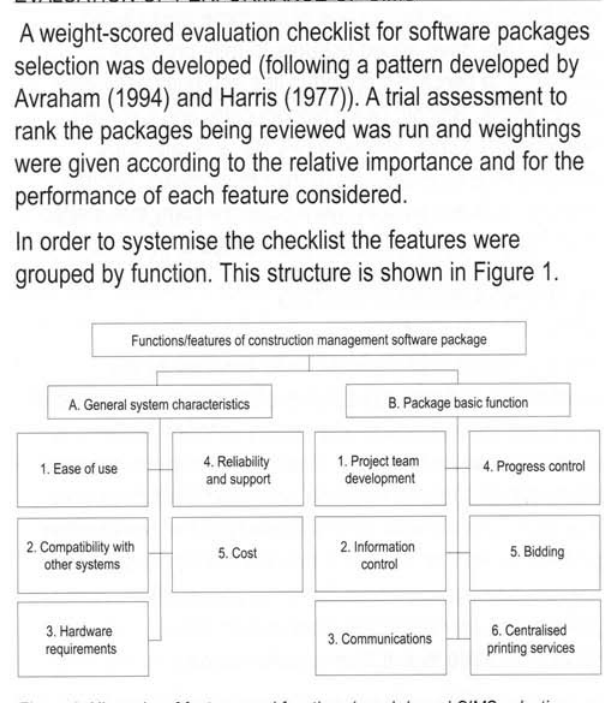
Figure 1: Hierarchy of features and functions in web-based elMS selection Each feature was assigned an 'importance ranking' or weighting value of 1 to 4 (marginally useful, useful, very useful, and essential). For its performance each feature was assigned a score from -1 to 3 (not available, poor, fair, satisfactory, and good). The final score of each package was then calculated as the sum of the products of the assigned weightings and performance of each